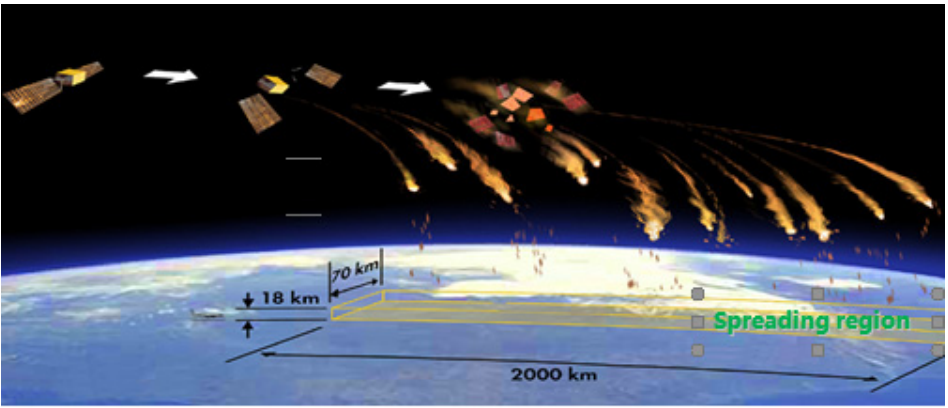
Figure 1. Schematic diagram of multiple disintegration process of expired spacecraft during re-entry near